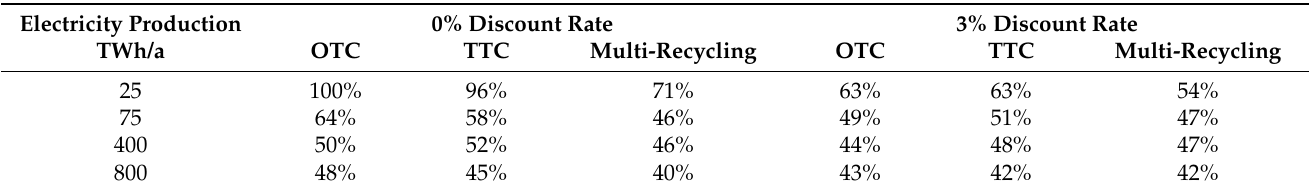
Table 10. LCOE values for the SNF management options analysed by Rodr í guez-Penalonga et al. [66], calculated as a percentage relative to the costs of the OTC for 25 TWh/a generation at a 0% discount rate (reported as USD 10.65 (2010)/MWh.